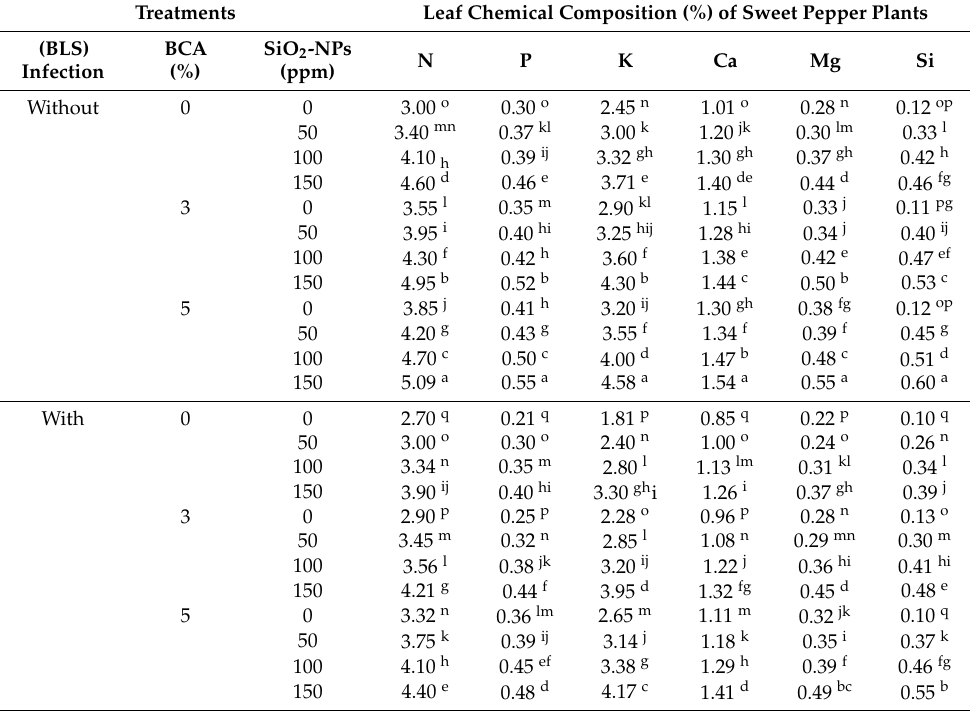
that increasing SiO 2 -NPs (ppm) and BCA (%) treatments without and/or with bacterial infection at harvesting time significantly increased all sweet pepper quality